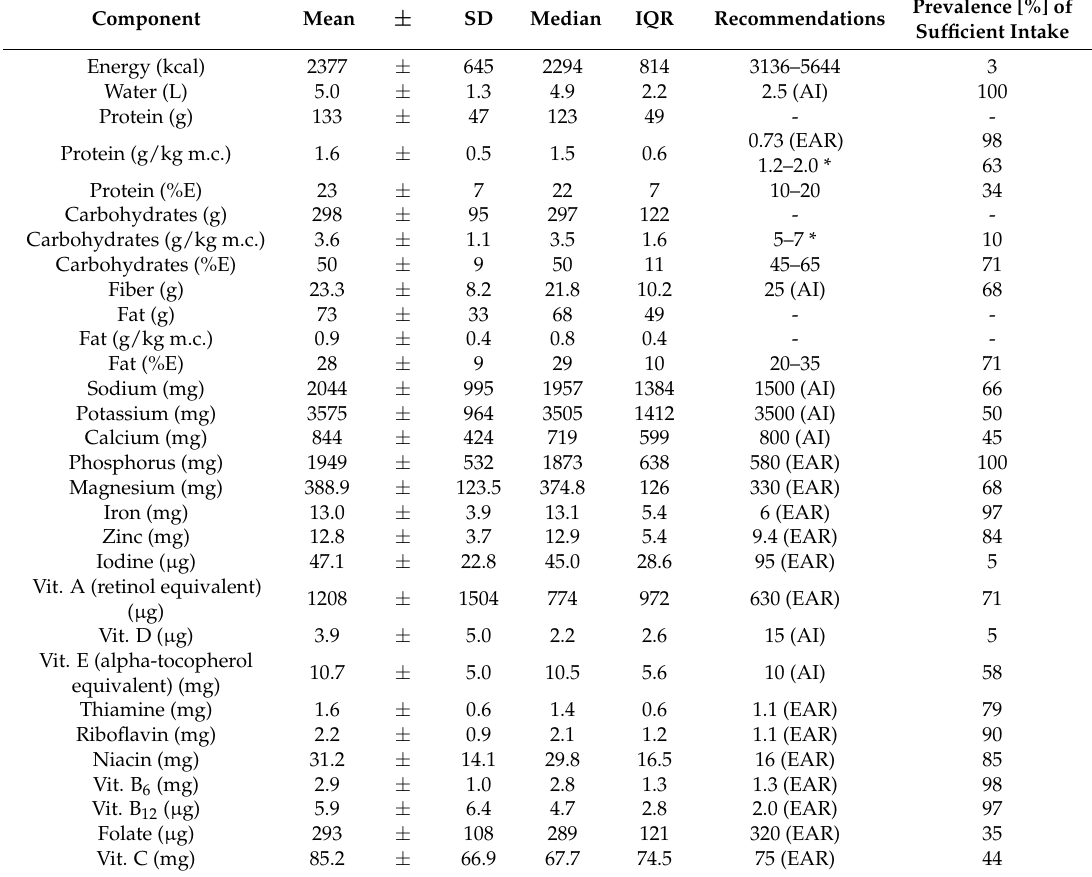
Table 2. Energy and Nutrient Intake on The Training Day ( n =